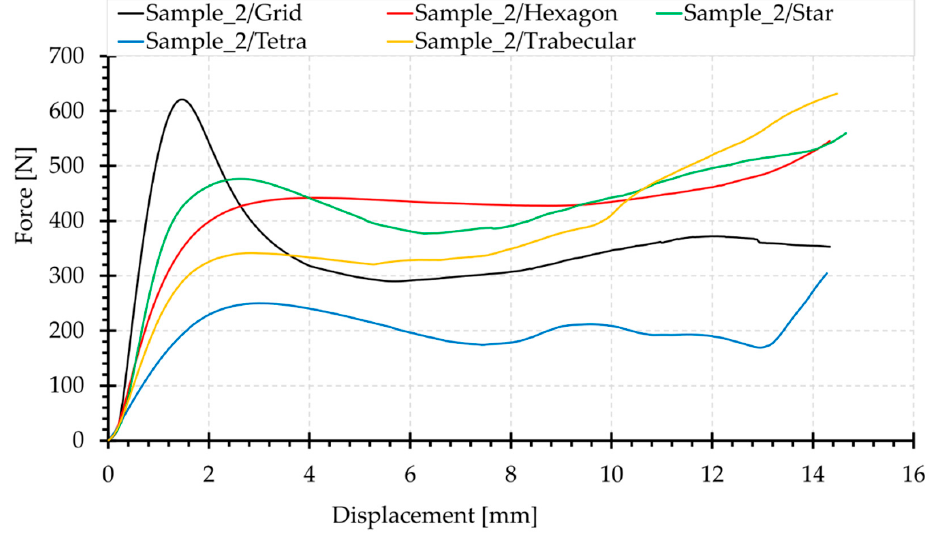
Figure 12. Summary of representative compression force–displacement curves, for the topologies analysed.